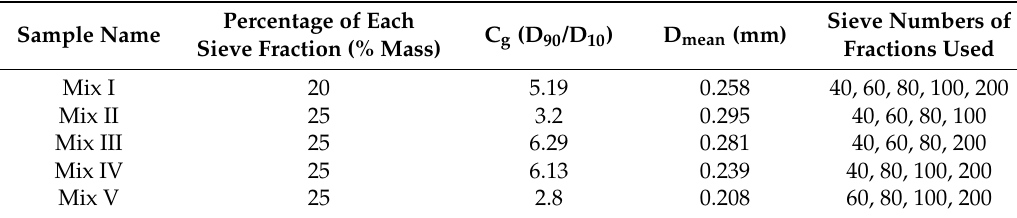
Table 2. Summary of experiments with mixed sands created by adding together well-sorted construction sand